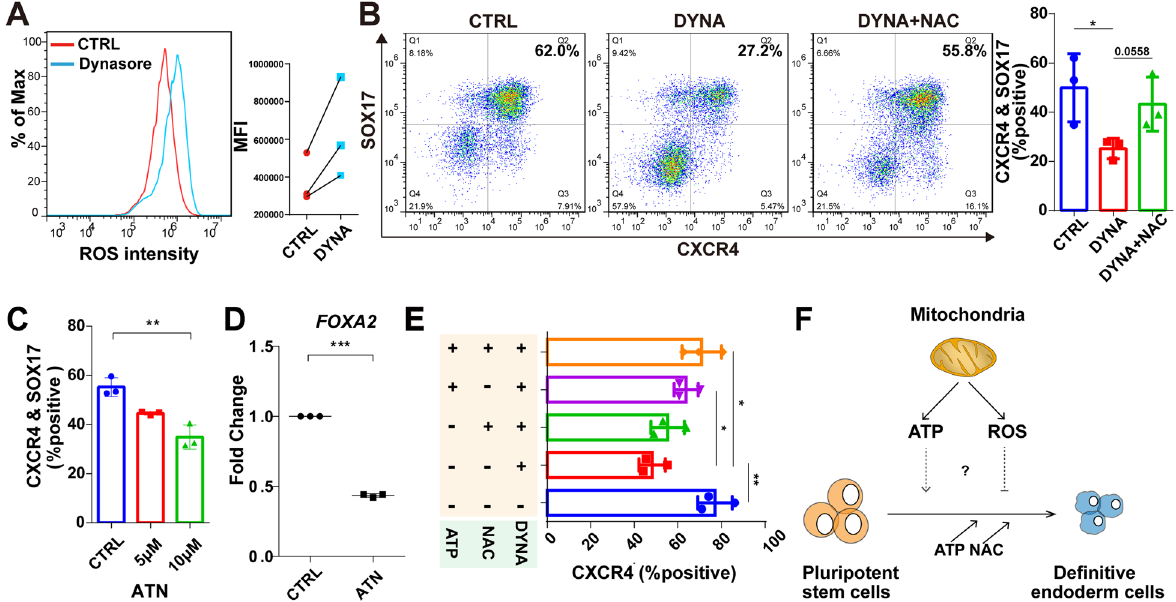
Fig. 5 The clearance of ROS can rescue the impaired DE differentiation due to mitochondrial dysfunction. A Flow cytometric analysis to determine the changes of intracellular ROS level during DE differentiation treated with (DYNA) or without (CTRL) dynasore. The mean fl uorescence intensity (MFI) of fl ow cytometry as shown on the right ( n = 3). B Flow cytometry analysis of DE marker with the treatment of dynasore, and dynasore plus 3 mM NAC, respectively ( n = 3). C Flow cytometry analysis of markers of DE cells when treated with ATN ( n = 3). D The mRNA expression of FOXA2 during DE differentiation treated with 10 μ M ATN. Data are normalized to the mRNA level of untreated (control) DE cells ( n = 3). E Percentage of CXCR4-positive cells ( fl ow cytometry) in the endoderm differentiation treated with 3 μ M dynasore, 1 mM NAC or 0.5 mM ATP ( n = 3). F Schematic illustration of mitochondrial regulation to DE differentiation. All data are shown as mean ± SD. * P < 0.05, ** P < 0.01 and *** P <